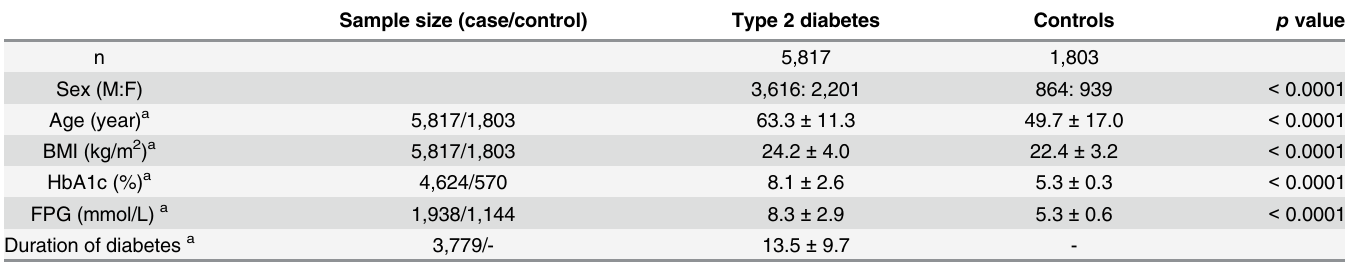
Table 1. Clinical characteristics of